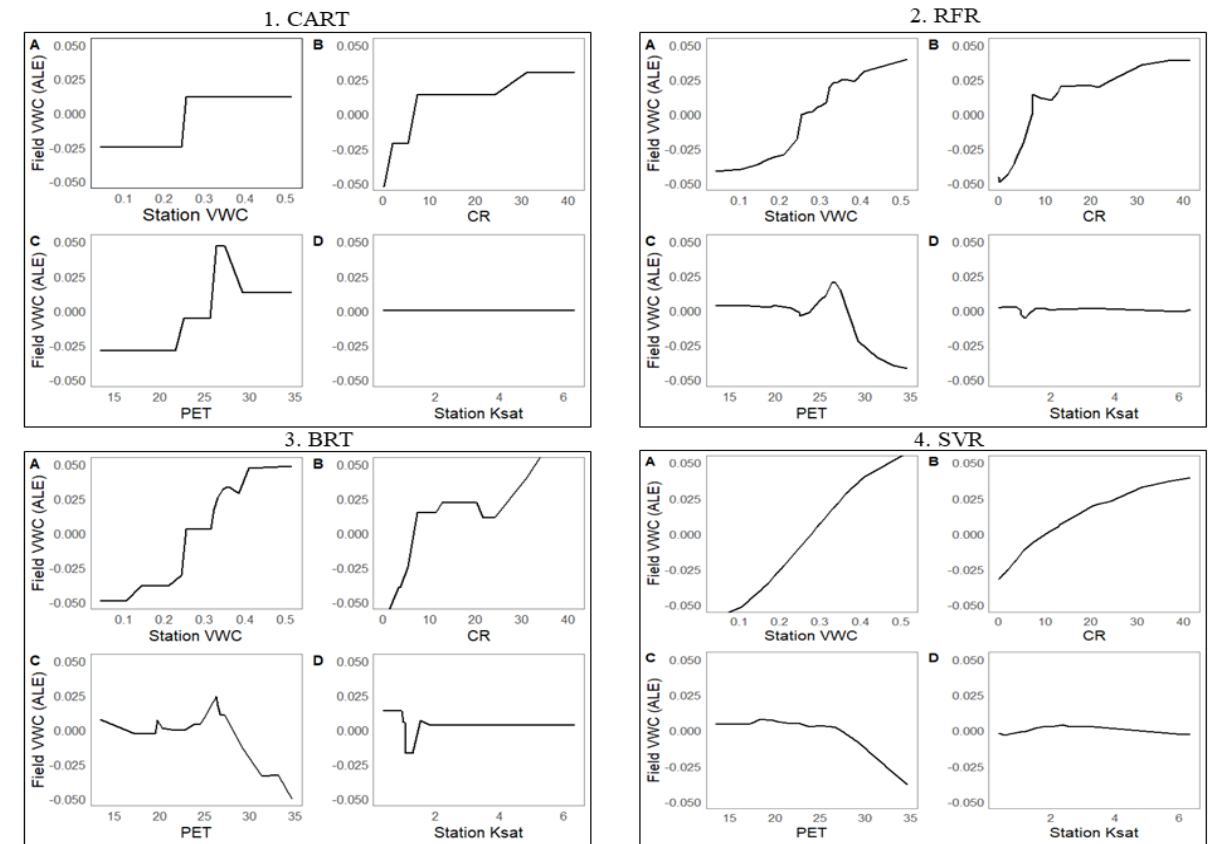
Figure 6. Accumulated local effect plots for ( A ) Station VWC, ( B ) 4-day cumulative rainfall (CR), ( C ) 4-day cumulative potential evapotranspiration (PET) and ( D ) weather station saturated hydraulic conductivity (Station Ksat) under 4 machine algorithms 1. Classification and regression trees (CART), 2. Random forest regression (RFR), 3. Boosted regression trees (BRT), and 4. Support vector regression (SVR) for model training datasets.